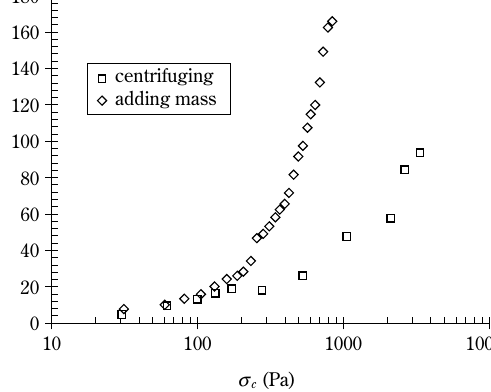
Fig. 9 Uniaxial tensile yield stress as a function of the apparent consolidation stress for the xerographic toner Canon CLC700 using different techniques of consolidation. One of them consists of adding mass to the sample contained in a cylindrical bed (diameter D (cid:2) 5.08 cm), where s c at the bottom would be given by r p (cid:2) f (cid:3) gh if wall effects are neglected. The other way of consolidation consists of cen- trifuging the bed. With the technique of adding mass, wall effects are not negligible for s c (cid:9)(cid:5) 200 Pa, corresponding to bed heights typically larger than the bed diameter ( h (cid:2) s c /( r p (cid:2) f (cid:3) g ) (cid:5) 5